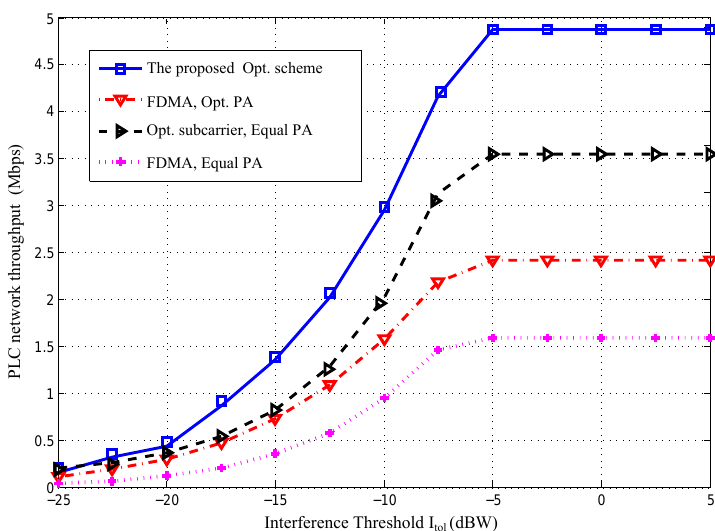
Figure 4. The PLC system throughput with the growth of the interference threshold under different resource